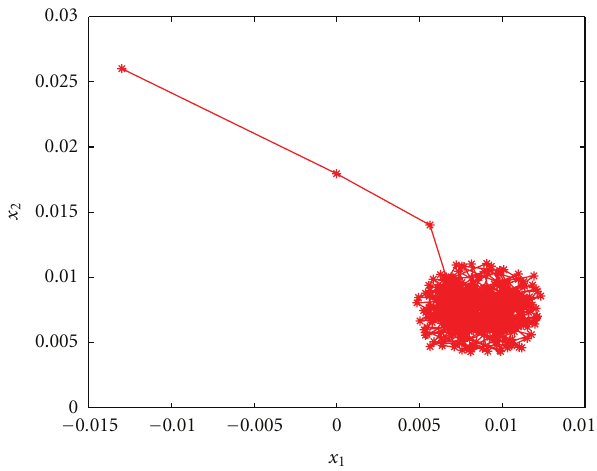
Figure 5: Phase response of state variables x 1 ,x 2 in Example